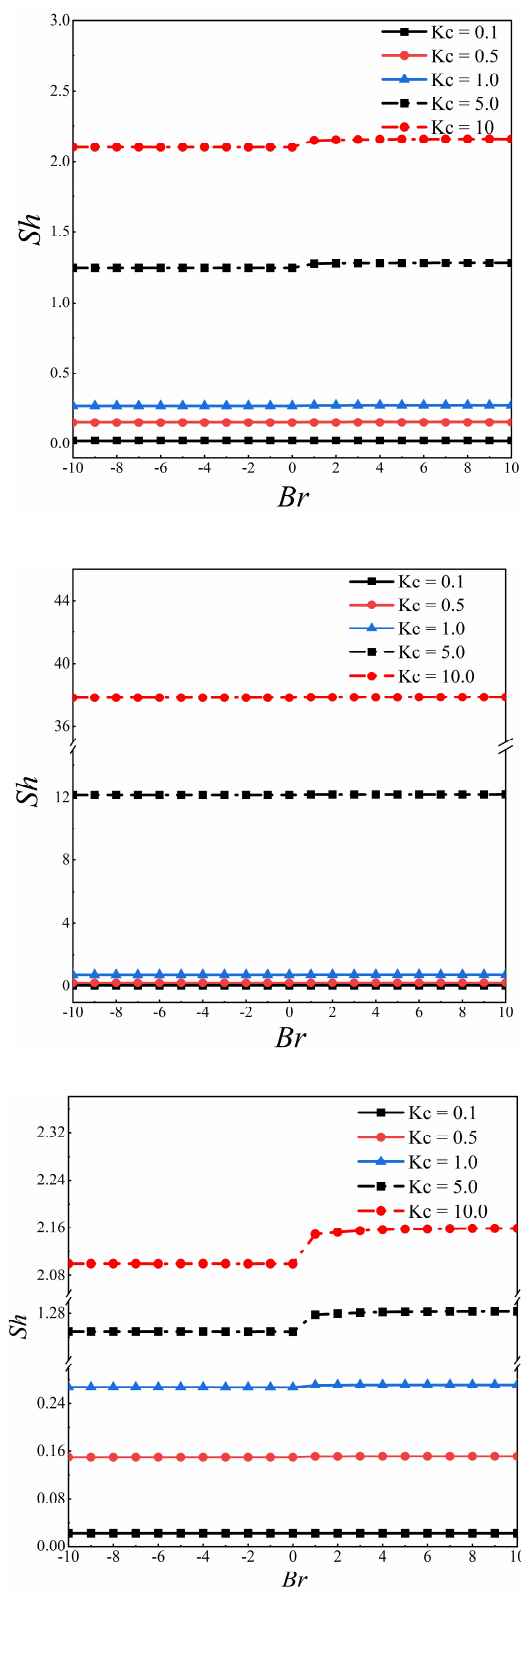
Figure 7. The effect of porous-fluid mass conductivity ratio and buoyancy ratio on heat and moisture transfer for three types of porous media arrangement at Ri = 1, Kr = 1, and Da = 10 − 3 . ( a ) Type A, ( b ) Type B, and ( c ) Type C.